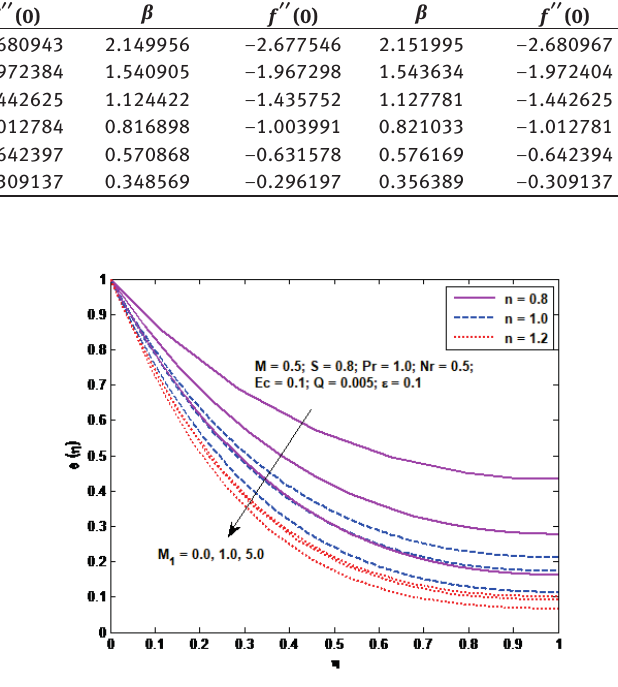
Fig. 4: Temperature profiles for different values of M 1